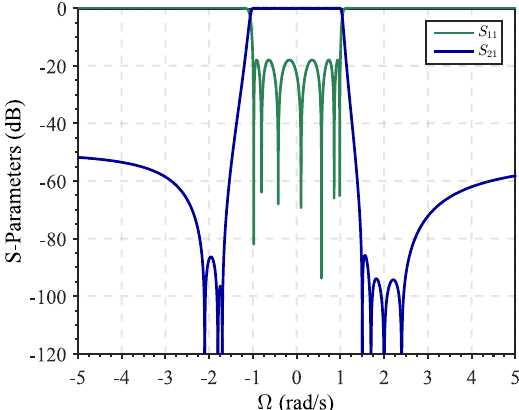
Figure 10. Lowpass transmission and reflection response of the extracted